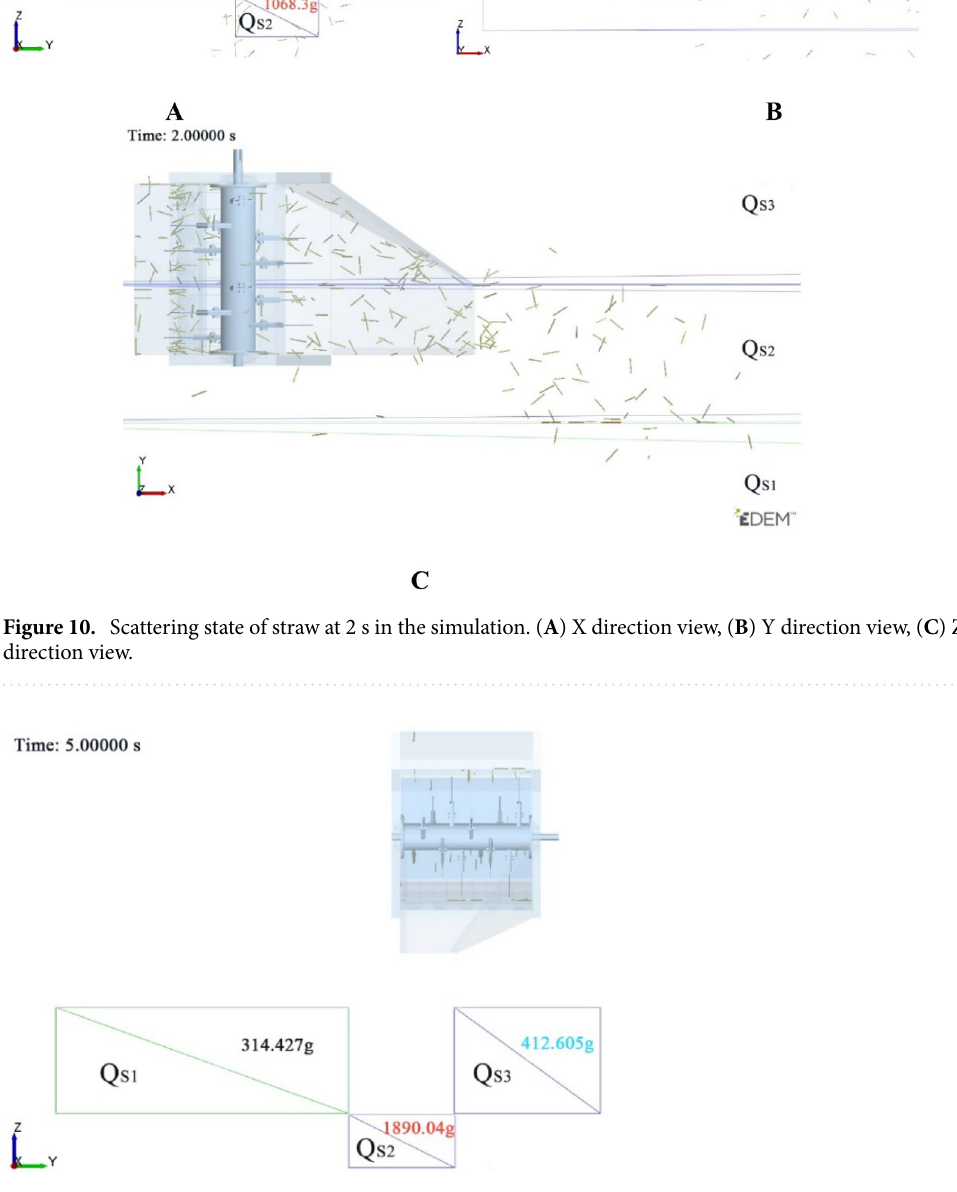
Figure 11. Scattering state of straw at 5 s in the